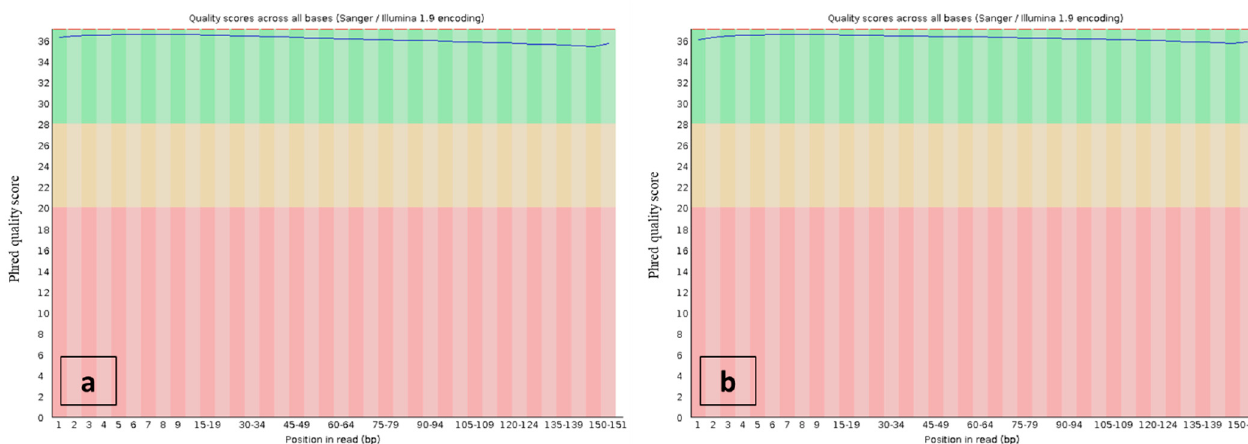
Figure 6. Phred quality scores throughout the read bases—dataset ready for genome size estimation— Reseda lutea ( a ) and Reseda pentagyna ( b ).